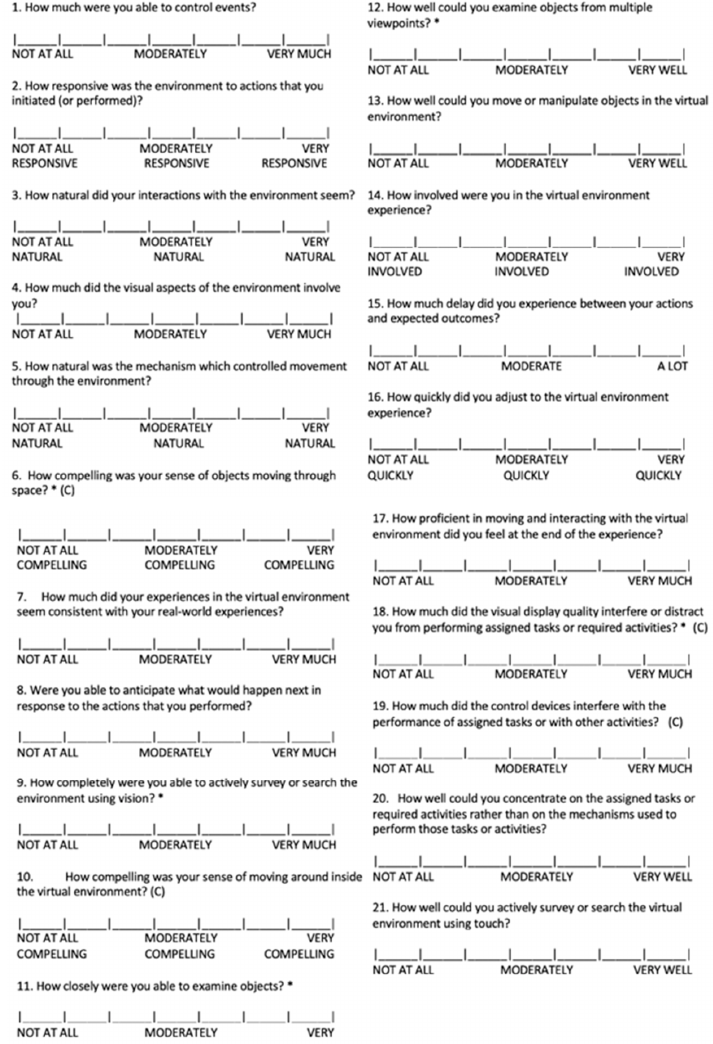
15 of 19 Acknowledgment: The 3D Models from “Figure 4”, “Figure 5”, “Figure 6” are from Make-Human, an open source tool for making 3D characters. The person in the video is the co-author Mr Anxhelino Mehmeti. The person in the photos “Figure 9”, “Figure 10” is the co-author Ms Chara Zoitaki. Funding: This research received no external funding Conflicts of Interest: The authors declare no conflict of interest Appendix The questionnaires for both the VR-HC and VR-MC experiments had the exact same questions, which are as follows (Appendix A1). The only difference were the titles: (i) Presence Questionnaire for the VR-HC System Simulation and (ii) Presence Questionnaire for the VR-MC System Simulation. The answer to each question was given in the same seven-point scale format that Witmer and Singer suggested. Questions regarding the auditory aspects of the environment were removed from the questionnaire, since there were no sounds involved in the virtual environments. These questions were: “How much did the auditory aspects of the environment involve you?”, “How well could you identify sounds?”, and “How well could you localize sounds?”. Questions marked